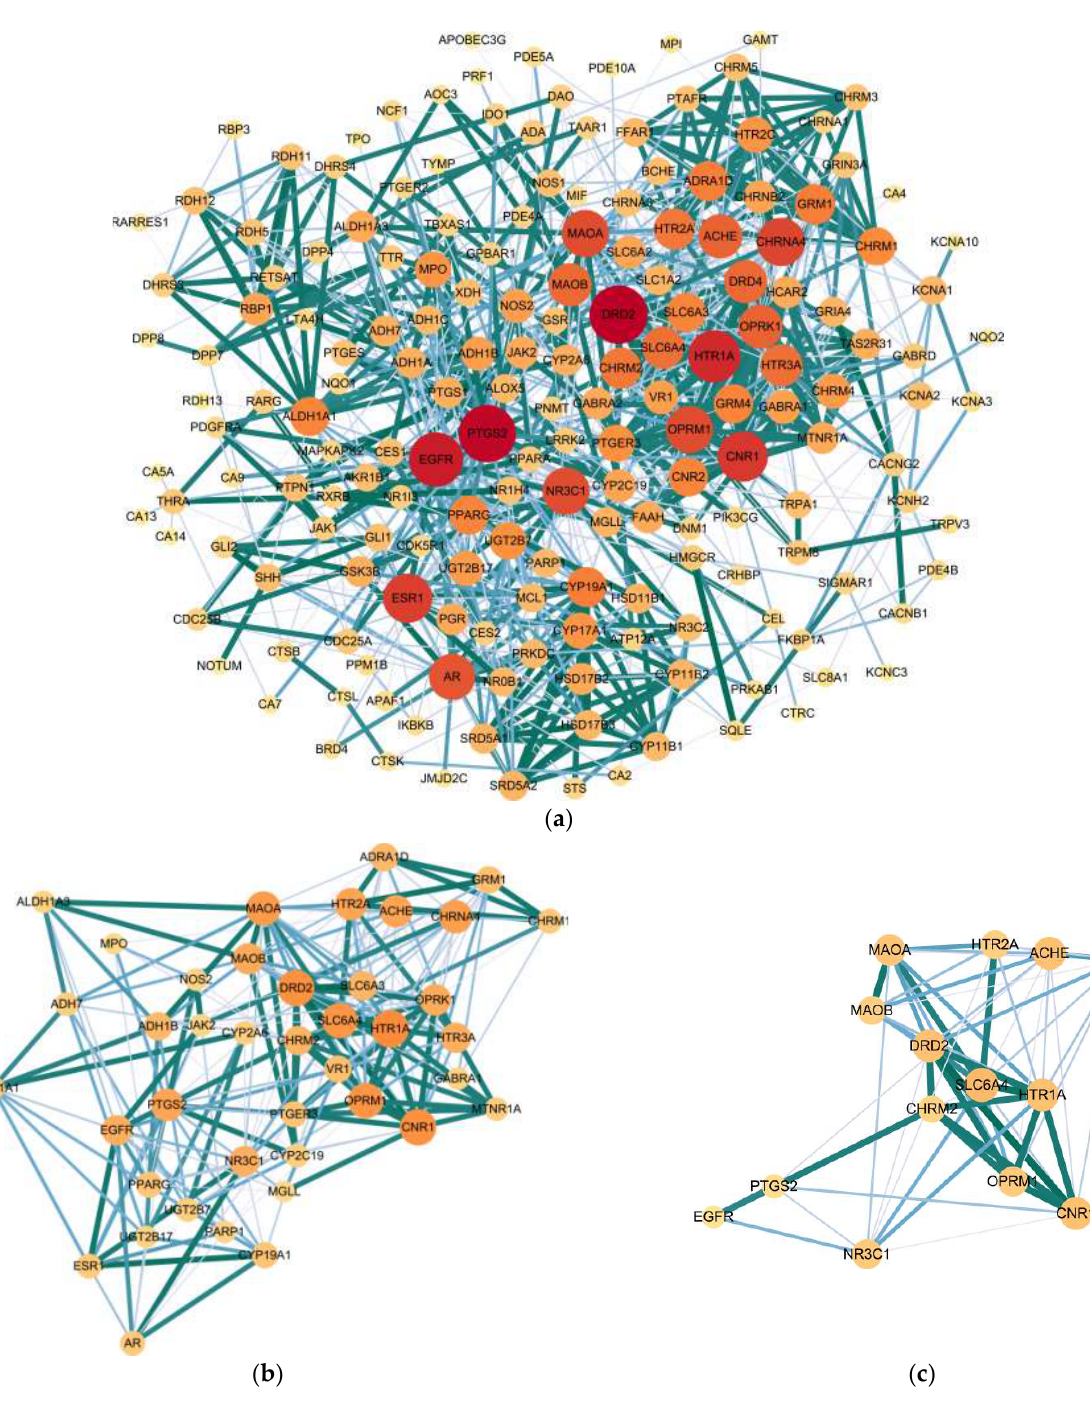
Figure 10. PPI network of the potential targets of essential oil compounds of woody peony. ( a ) Total network consisting of all connected nodes (183 targets); ( b ) Subnetwork consisting of 41 targets after first filtering applied; ( c ) Core network consisting of 14 targets after second filtering applied. The size and color of each node is representative of its degree value within the present network. The line width and color of each edge is representative of the combined interaction score. Table 4. Ranking of all the 14 core targets in the PPI core network.